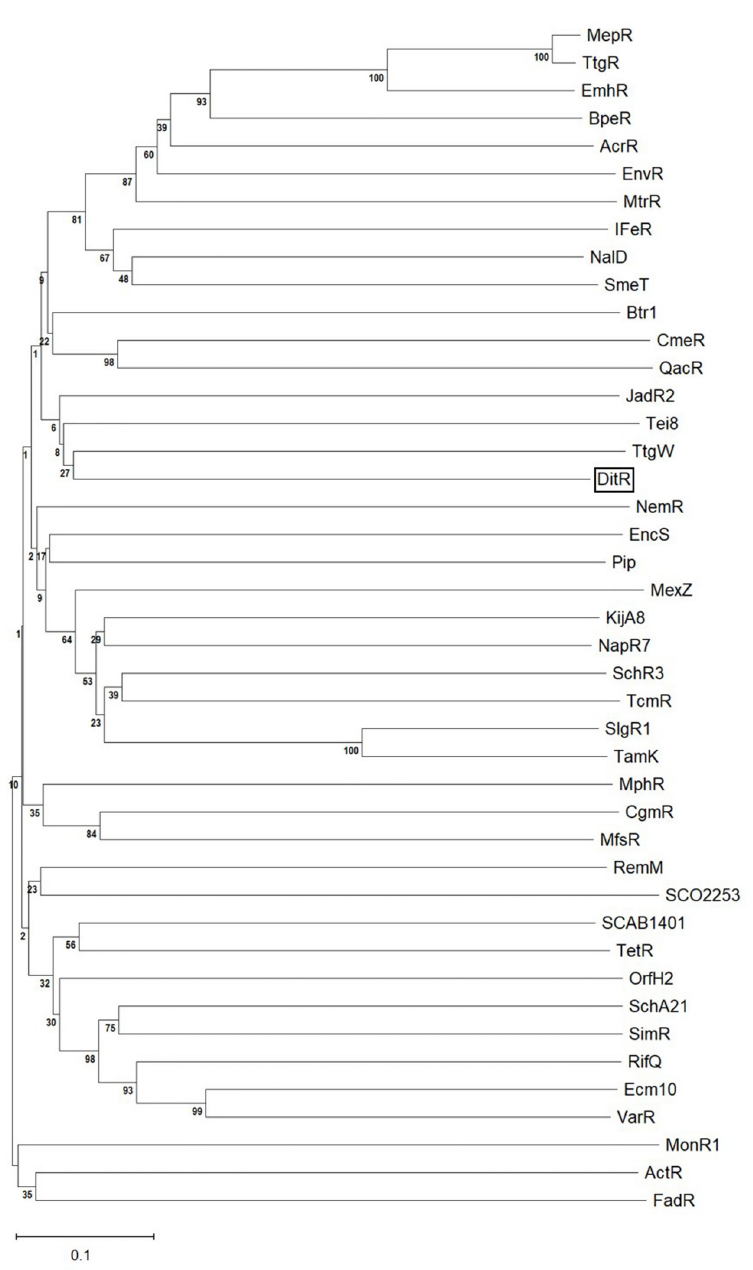
Fig 6. Phylogenetic analysis of S . maltophilia DitR. Phylogenetic analysis was constructed by Molecular Evolutionary Genetics Analysis (MEGA) version 11 using neighbor-joining method with 500 bootstraps. Amino acid sequences of known transcription regulators belonging TetR family from various bacteria were retrieved from the NCBI databases; AcrR (NP_414997.1), ActR (WP_012067478.1), BpeR (WP_004526226.1), Btr1 (BAE07057.1), CgmR